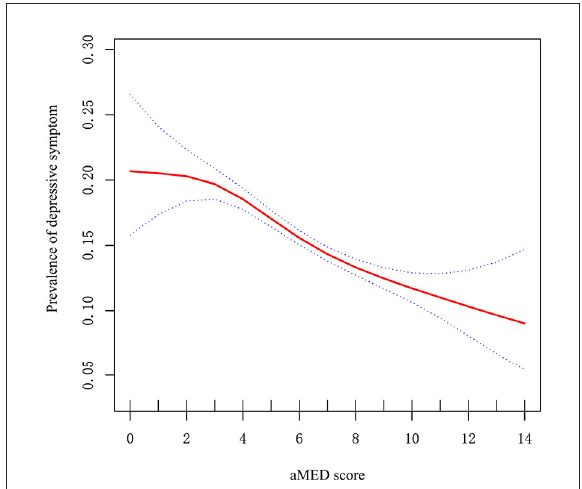
FIGURE1 Non-linear relationship between aMED score and prevalence of depressive symptom. X-axis: aMED score; Y-axis: prevalence of depressive symptom. Red: OR; blue circles: 95%